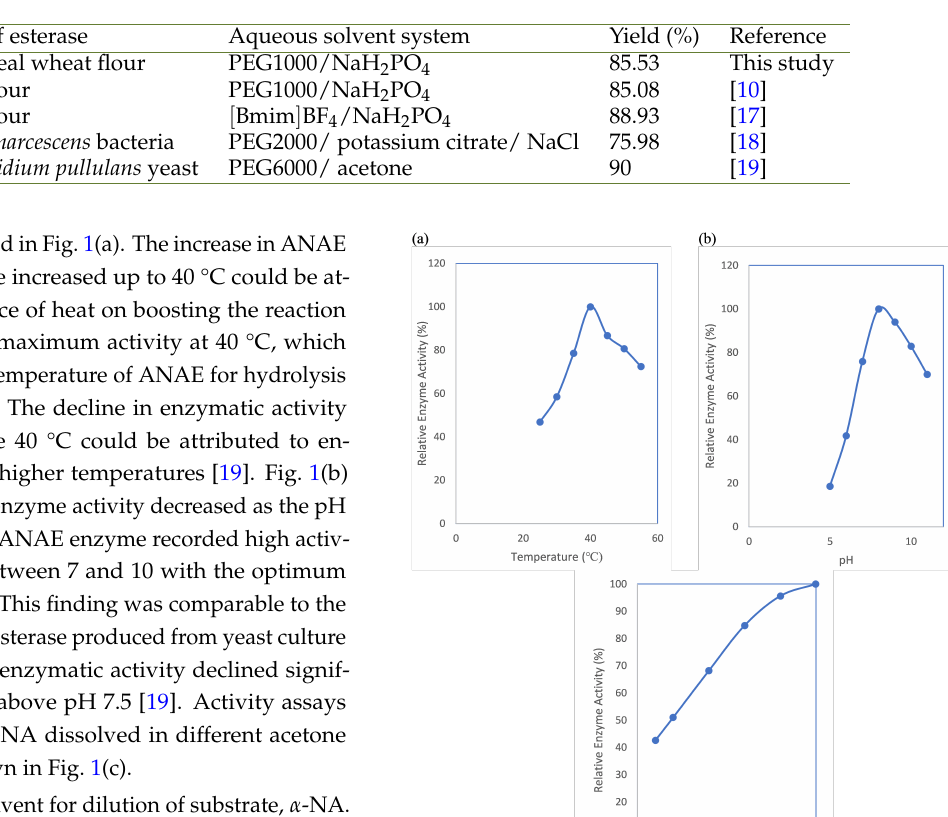
Table 2. Esterase extraction from various source of biomass and purification using ATPS